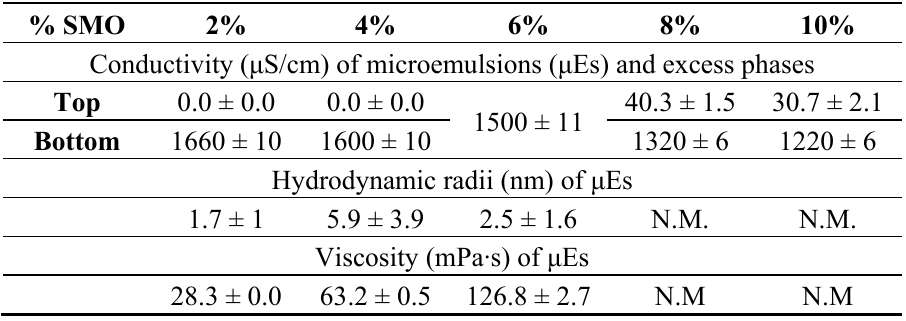
Table 3. Properties of the μ Es produced with the phase scan (2–10% sorbitol monooleate—SMO) of Figure 1 (see Table 1 for additional composition details) at room temperature (25 ± 1